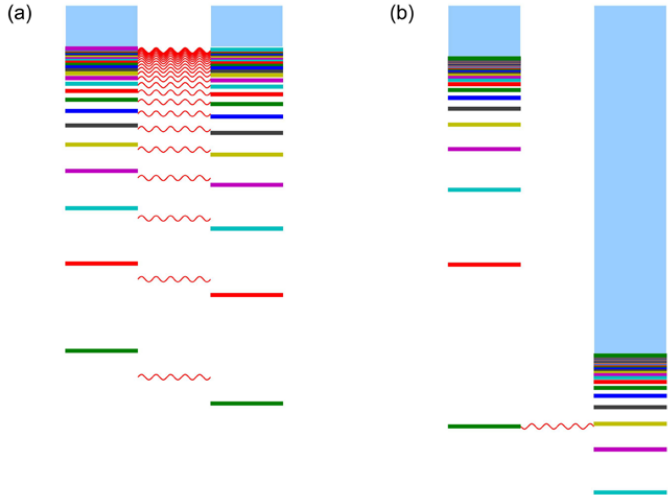
Figure 1. Different natures of the perturbation prevail depending on whether the autoionizing Rydberg series converge to the same limit as in ( a ) or to the different limits as in ( b ). In contrast to the case of ( b ) for which the perturbation shown by a wiggling line is local in energy, for case ( a ), the perturbations shown with a wiggling line are not local and act uniformly throughout the entire series (from [29]).